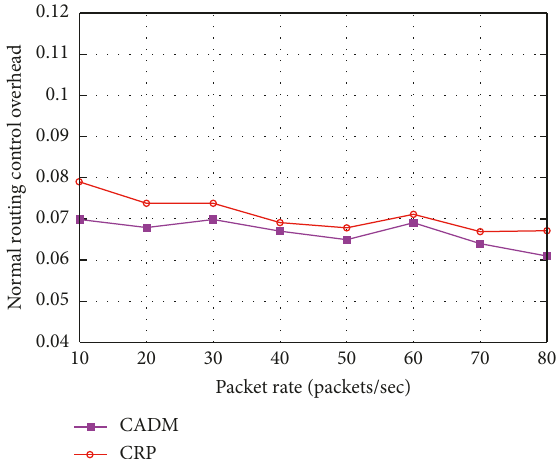
Figure 6: Normalized control overhead with varying packet rates.